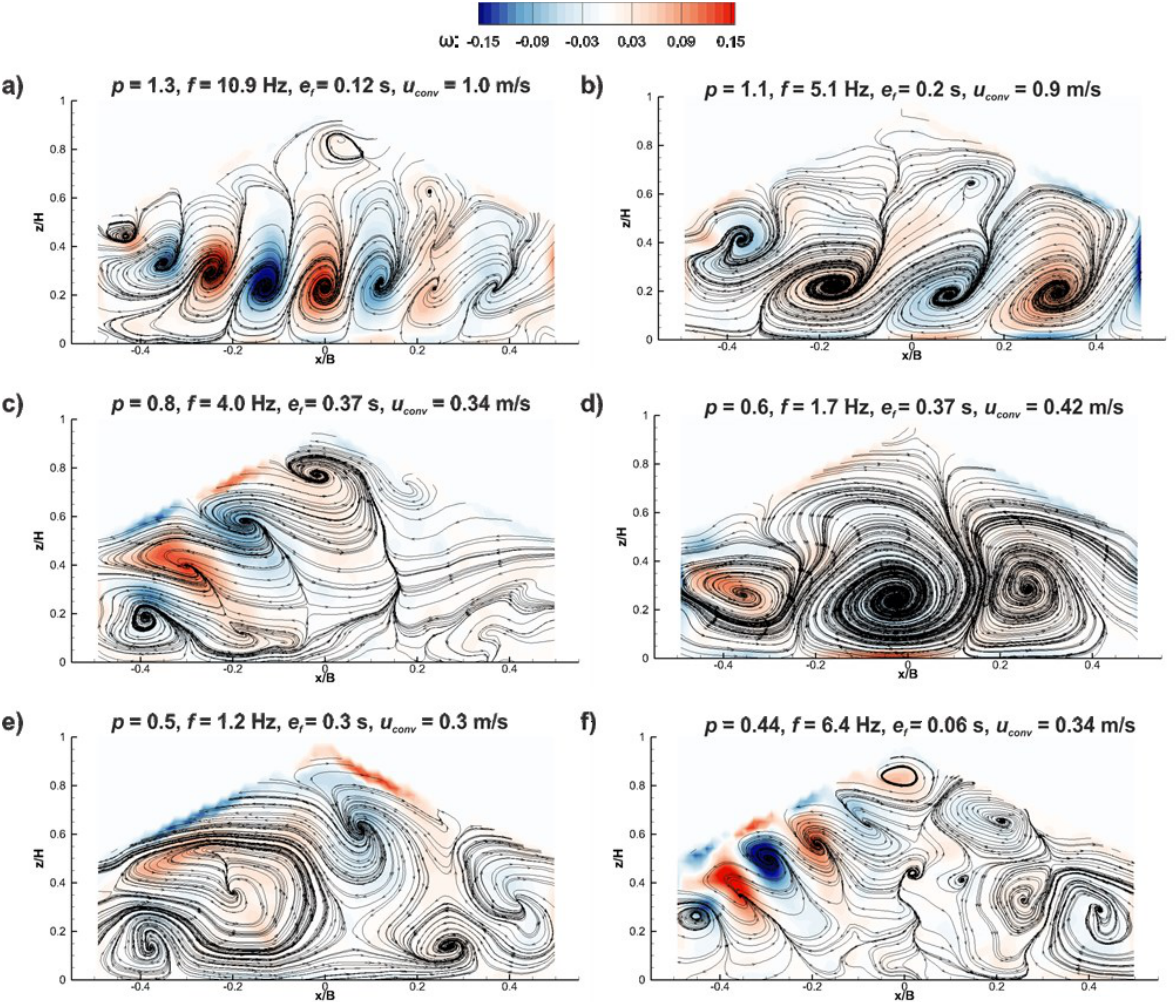
Fig. 6. Spatial OPD modes of the fully ( a,b ), half ( c,d ) and quarterly ( e,f ) opened configuration having the second ( a,c,e ) and third ( b,d,f ) highest periodicity. Only the real parts of the OPD modes at phase 0 are presented for the sake of